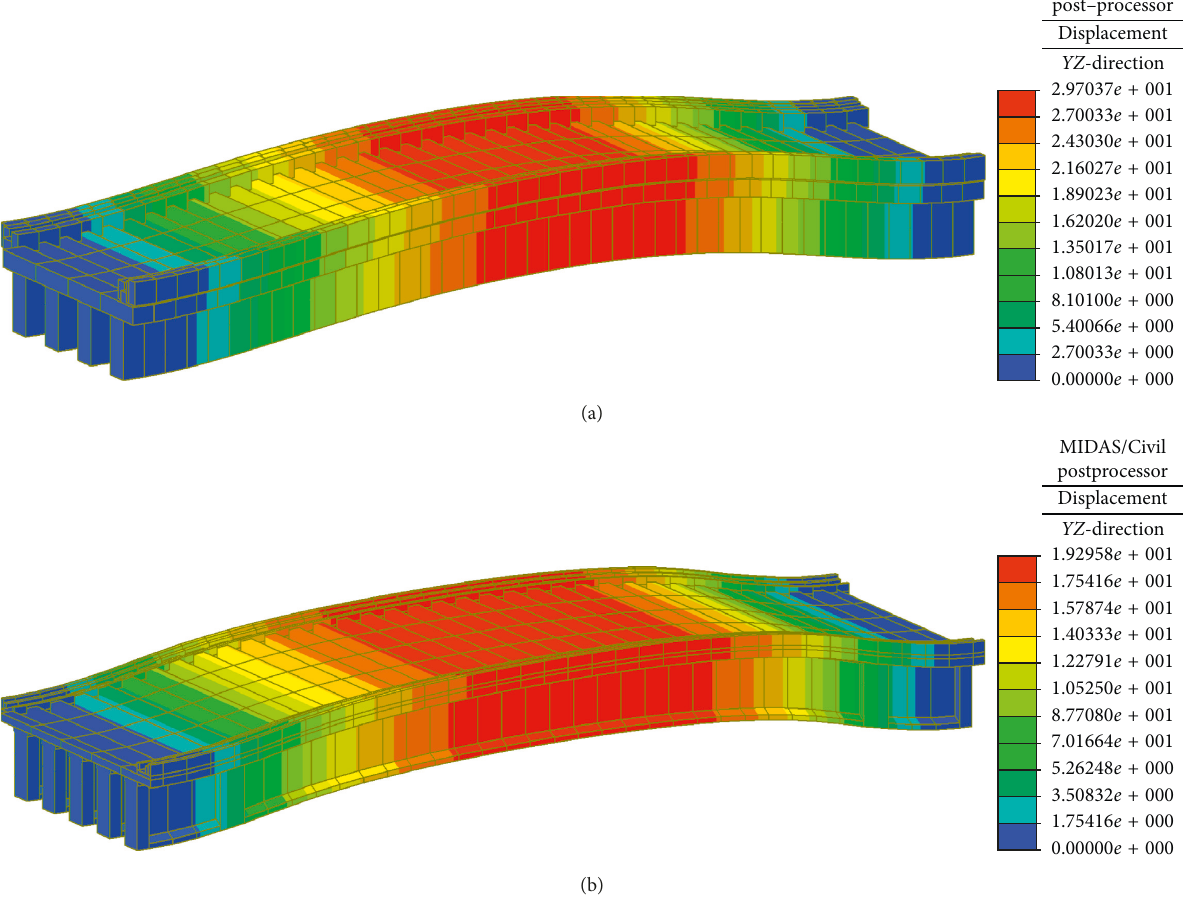
Figure 4: Analysis result of final deformation of bridges (a) A and (b)